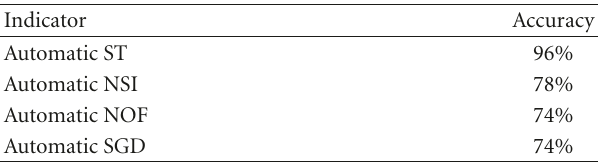
Table 3: Dominance classification results using independent automatic-extracted dominance indicators.